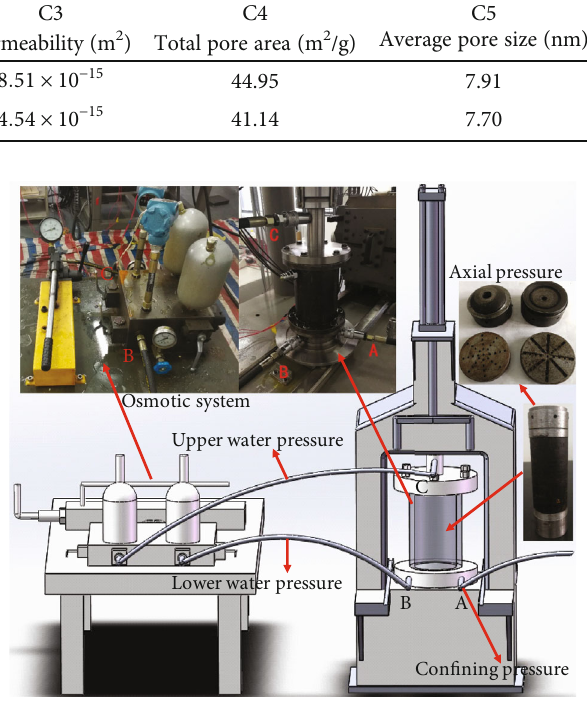
Figure 5: The schematic diagram of the penetration test